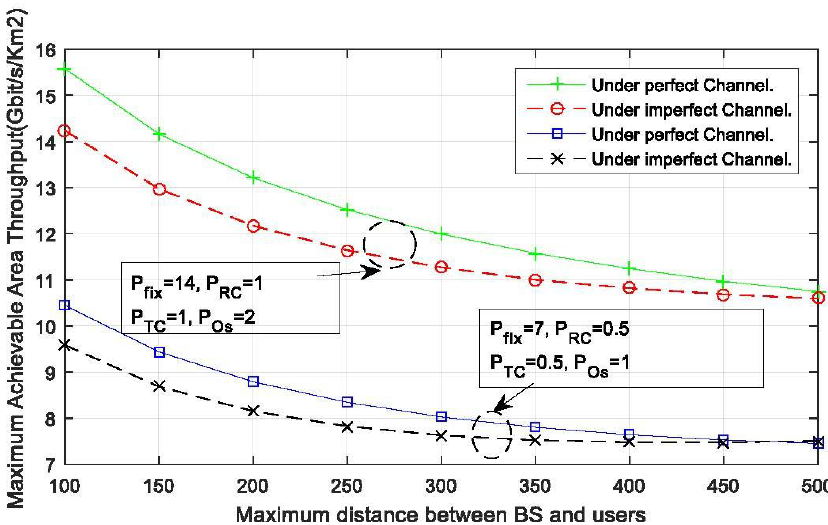
Figure 8. Optimal Power of non-linear amplifiers. Figure 9. Area throughput.